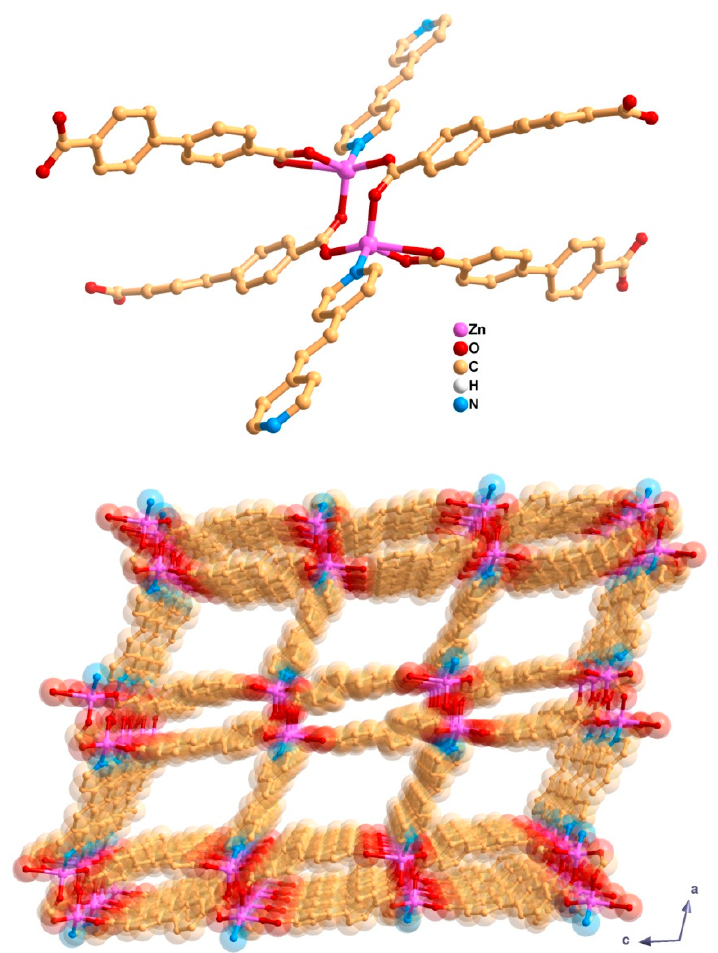
Figure 1. Selected structural features of [Zn 2 (bpdc) 2 (bpee)]: the secondary building unit showing the coordination environment of the Zn(II) centers ( top ) and crystalline packing arrangement revealing channels along the b -axis of the unit cell ( bottom ). For clarity, the H-atoms are omitted. The images were prepared from the original CIF file deposited in the Cambridge Structural Database (entry code COWPOU).